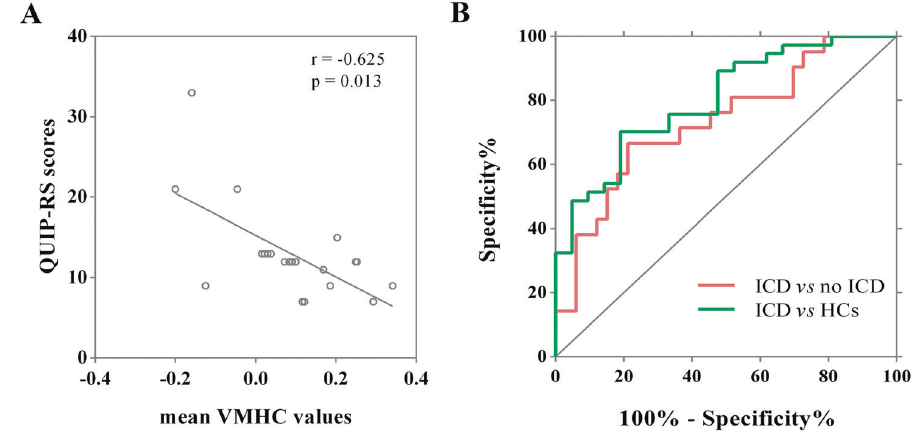
Fig. 2 Correlation between VMHC values and QUIP-RS scores of PD-ICD patients and ROC analyses for differentiating different groups. Scatterplots demonstrated that there was a signi fi cant negative correlation between the mean VMHC values in the middle frontal gyrus and QUIP-RS scores in PD patients with ICD. The graph showed the results of the ROC analyses for differentiating different groups. VMHC voxel- mirrored homotopic connectivity, QUIP-RS Questionnaire for Impulsive-Compulsive Disorders in Parkinson ’ s Disease Rating Scale, PD Parkinson ’ s Disease, ICD impulse control disorders, ROC receiver operating characteristic, AUC area under the curve, CI con fi dence interval, HCs healthy